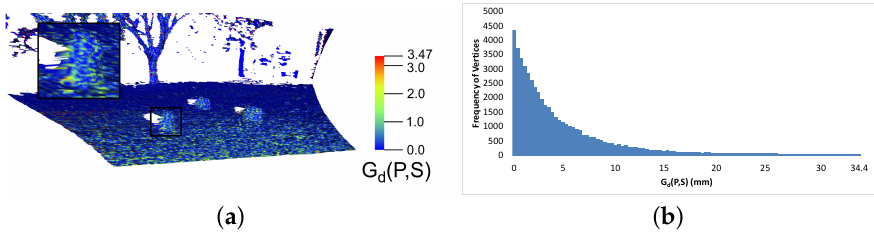
Figure 25. Surface plot of G d ( P , S ) for an outdoor environment ( a ) and the respective histogram ( b